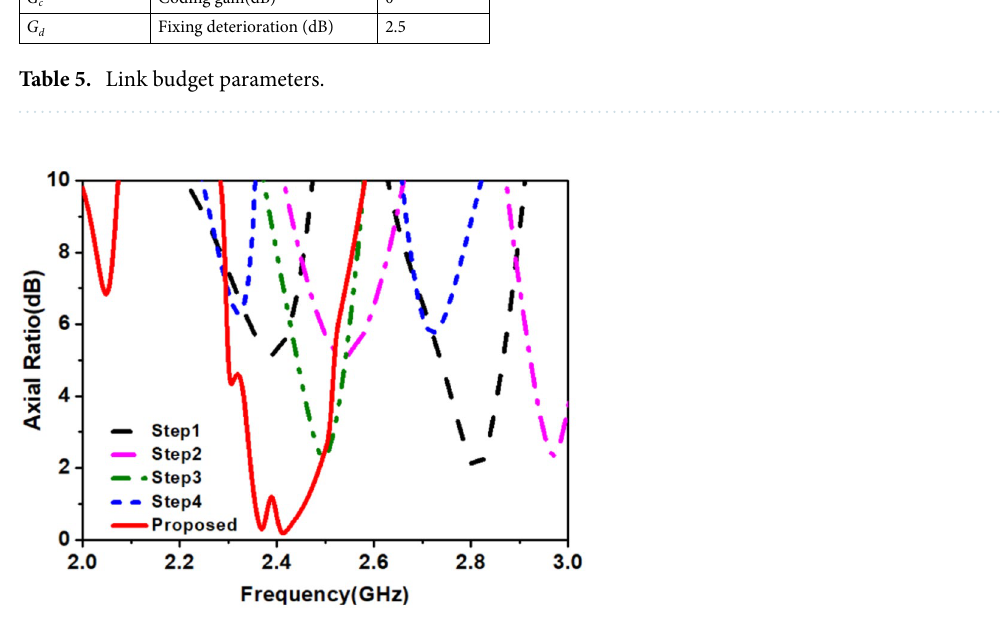
Figure 10. Simulated axial-ratio plots of optimization steps.